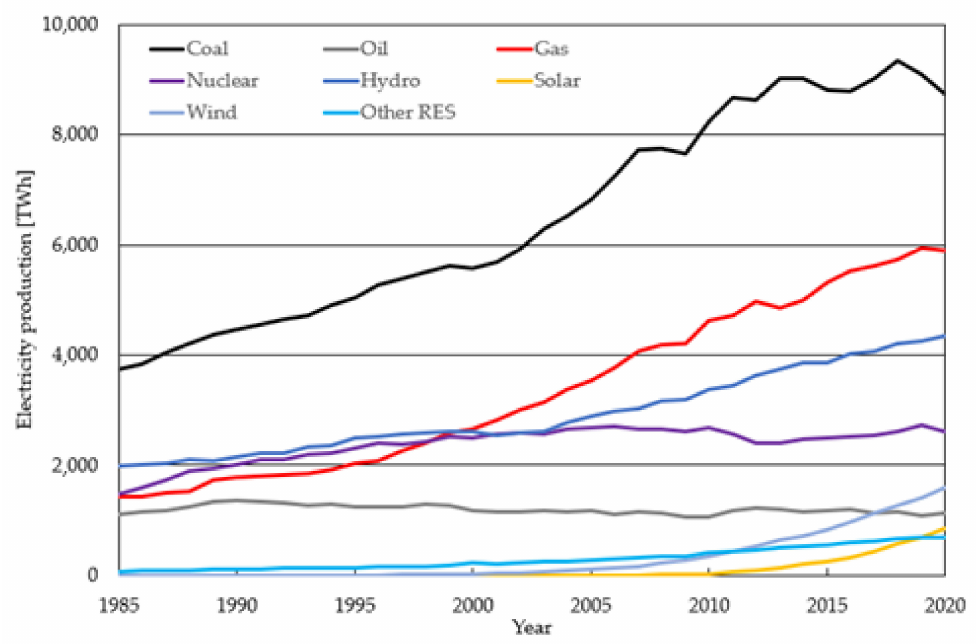
Figure 4. Global electricity production by source (1985–2020)